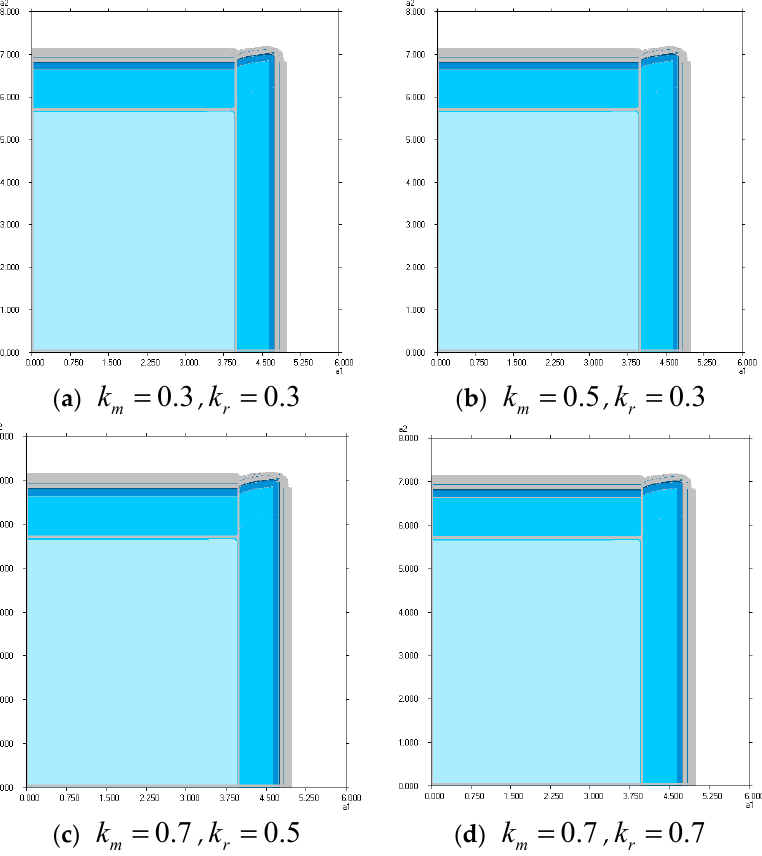
α α and with different 1 2